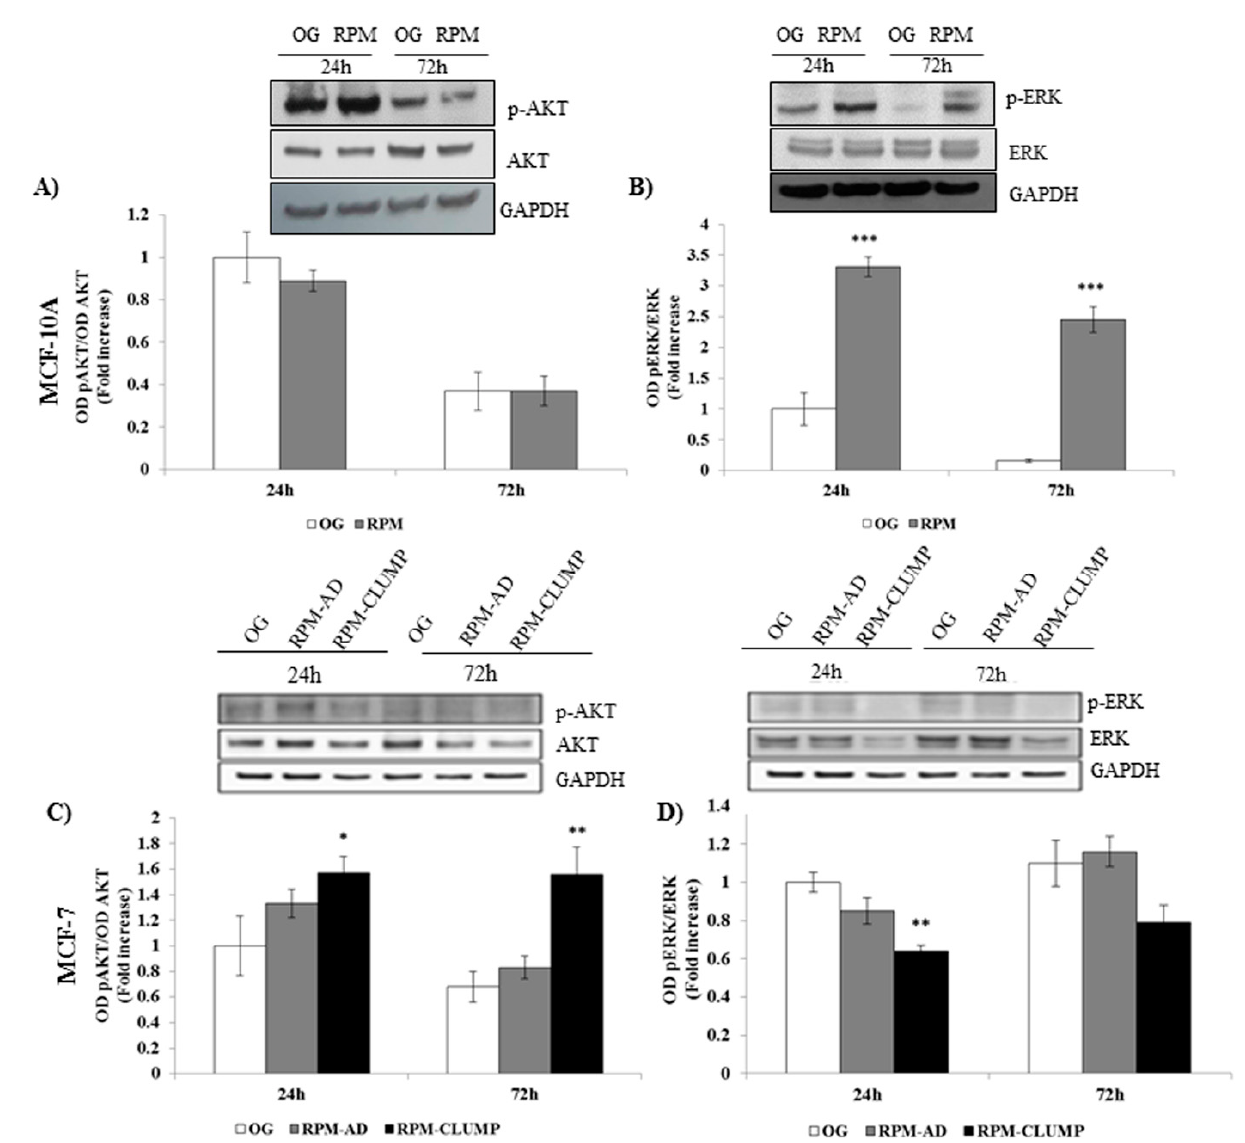
Figure 11. Immunoblot bar chart showing the expression of the phosphorylated AKT (p-AKT)/AKT ratio and p-ERK/ERK ratio in MCF-10A ( A , B ) and MCF-7 ( C , D ) in on-ground control cells, RPM adherent cells, and RPM cell clumps at 24 and 72 h. Columns and bars represent densitometric quantification of the optical density (OD) of a specific protein signal normalized with the OD values of the GAPDH serving as the loading control. Each column represents the mean value ± SD of three independent experiments. In MCF-10A, *** p < 0.001 vs. OG by t test; in MCF-7, * p < 0.05, ** p < 0.01 vs. OG by ANOVA followed by Bonferroni post-test.